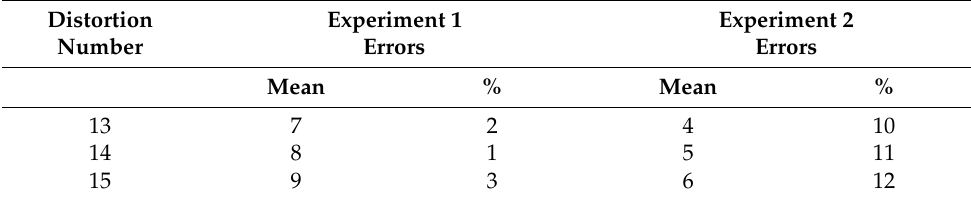
Table 4. Errors for the FEI image